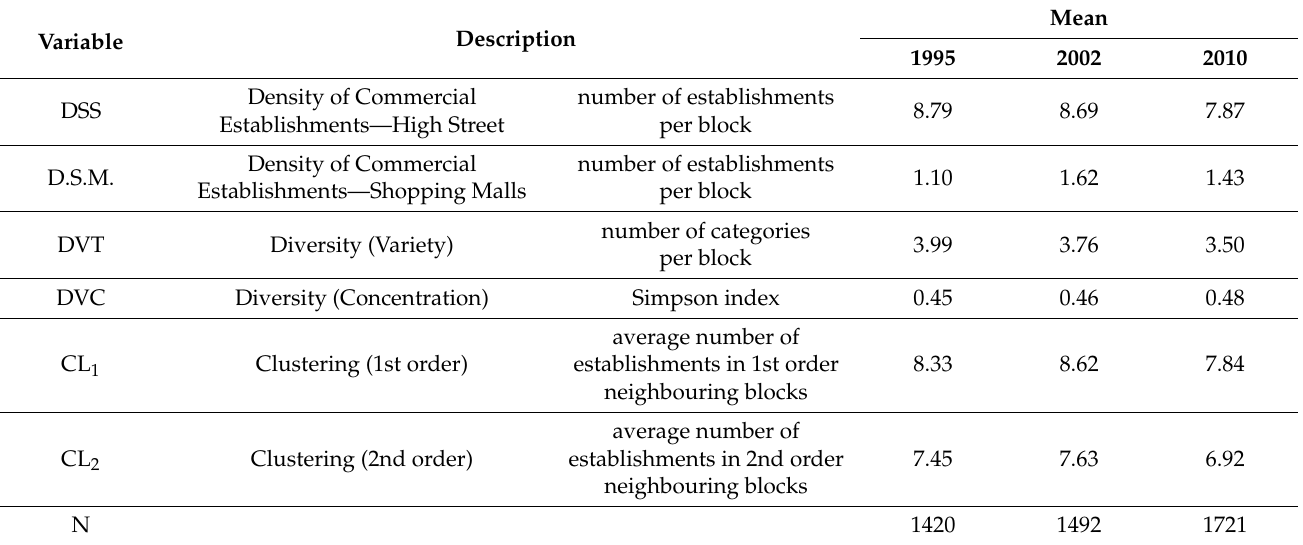
Table 1. Summary of the